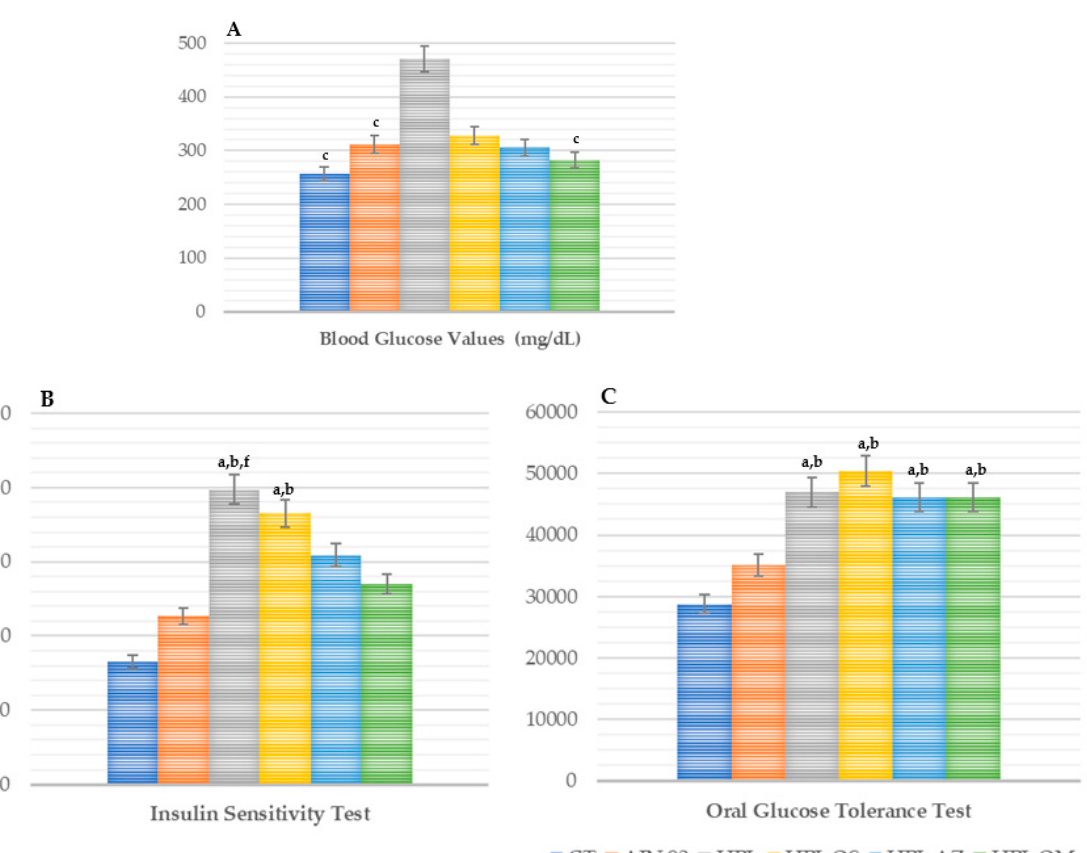
Figure 5. Blood glucose values (mg/dL) ( A ), area under the curve of the insulin sensitivity test (%) ( B ), and oral glucose tolerance test (%) ( C ) of animals fed a balanced or high-fat diet and supplemented with saline, soybean oil, olive oil, or seed oil of papaya ( Carica papaya Linn). Values expressed as mean ± standard deviation. The letters indicate statistical difference as follows: a compared to CT; b compared to AIN 93; c refers to the oral glucose tolerance test (%) f compared to HPL OM. p < 0.001. n = 14–18. ANOVA followed by Tukey post test.